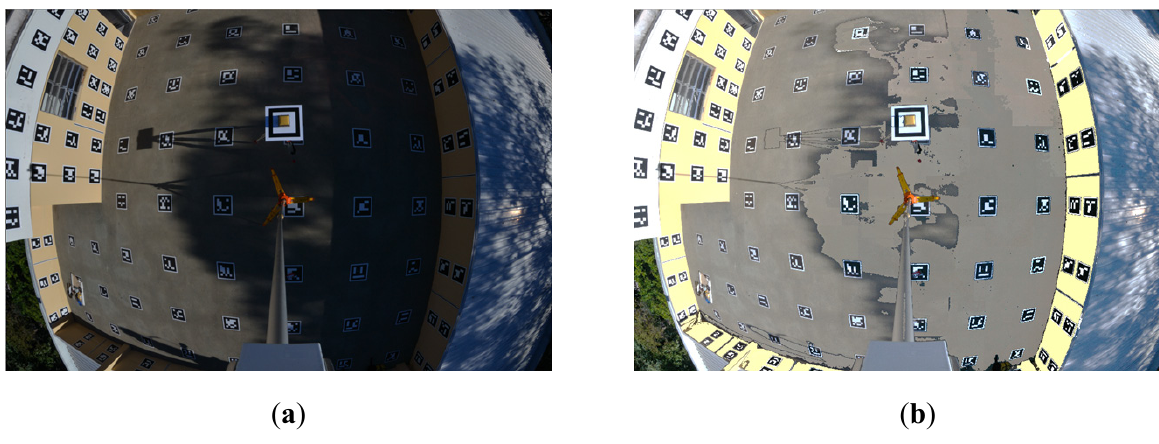
Figure 3. ( a ) Original image with shadow. ( b ) Image after the shadow labeling and